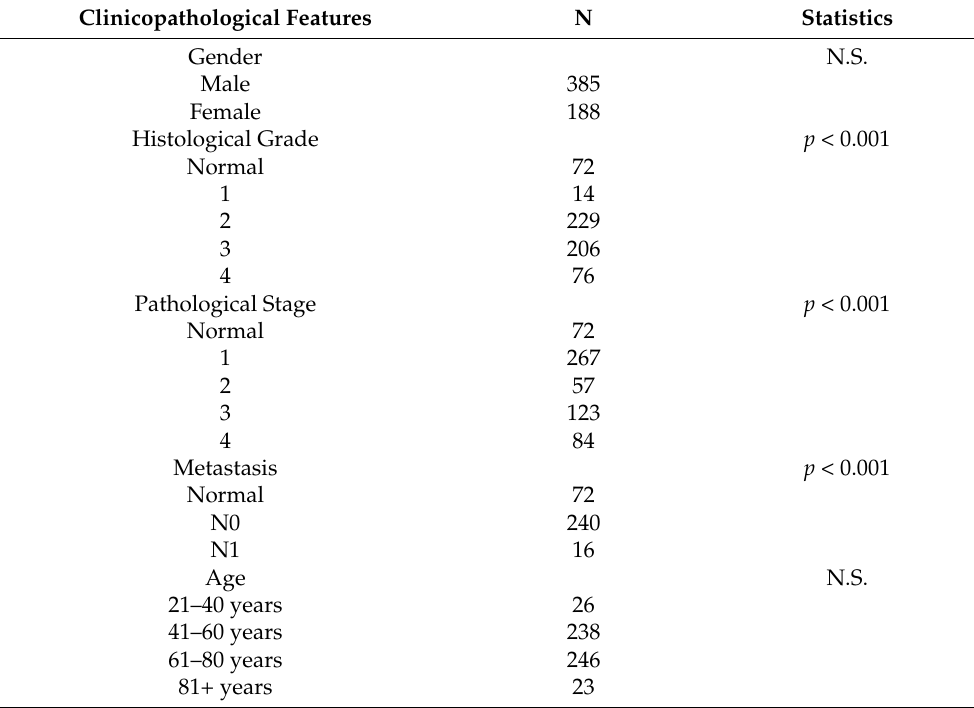
Table 1. Clinicopathological features of the ccRCC TCGA dataset. A t -test was conducted to analyze differential gene expression of ZNF433 between genders. ANOVA was used to analyze ZNF433 gene expression across clinicopathological features. Statistical significance was set at p < 0.05. N.S. = not significant ( p > 0.05). Clinicopathological Features N Statistics Gender